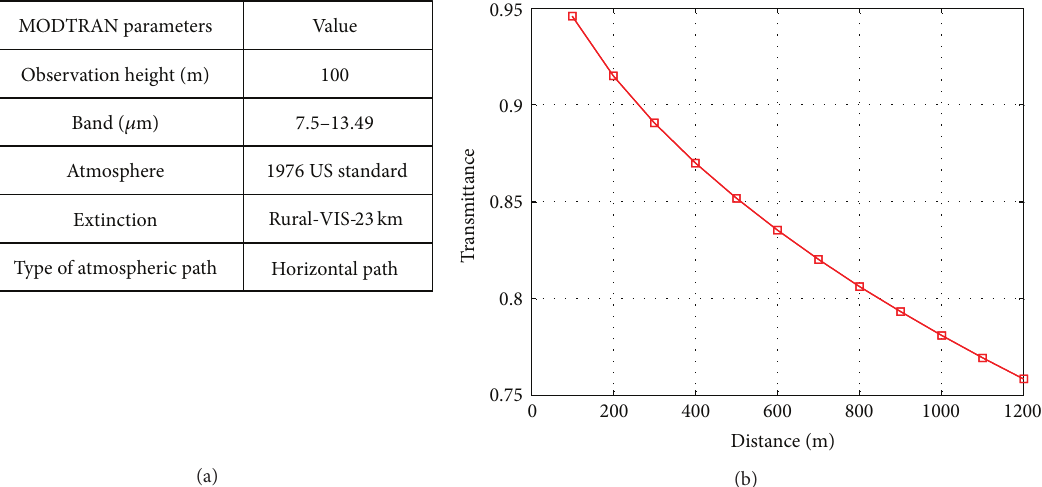
Figure 6: MODTRAN simulation of the recording environment: (a) selected MODTRAN parameters, (b) transmittance versus distance.